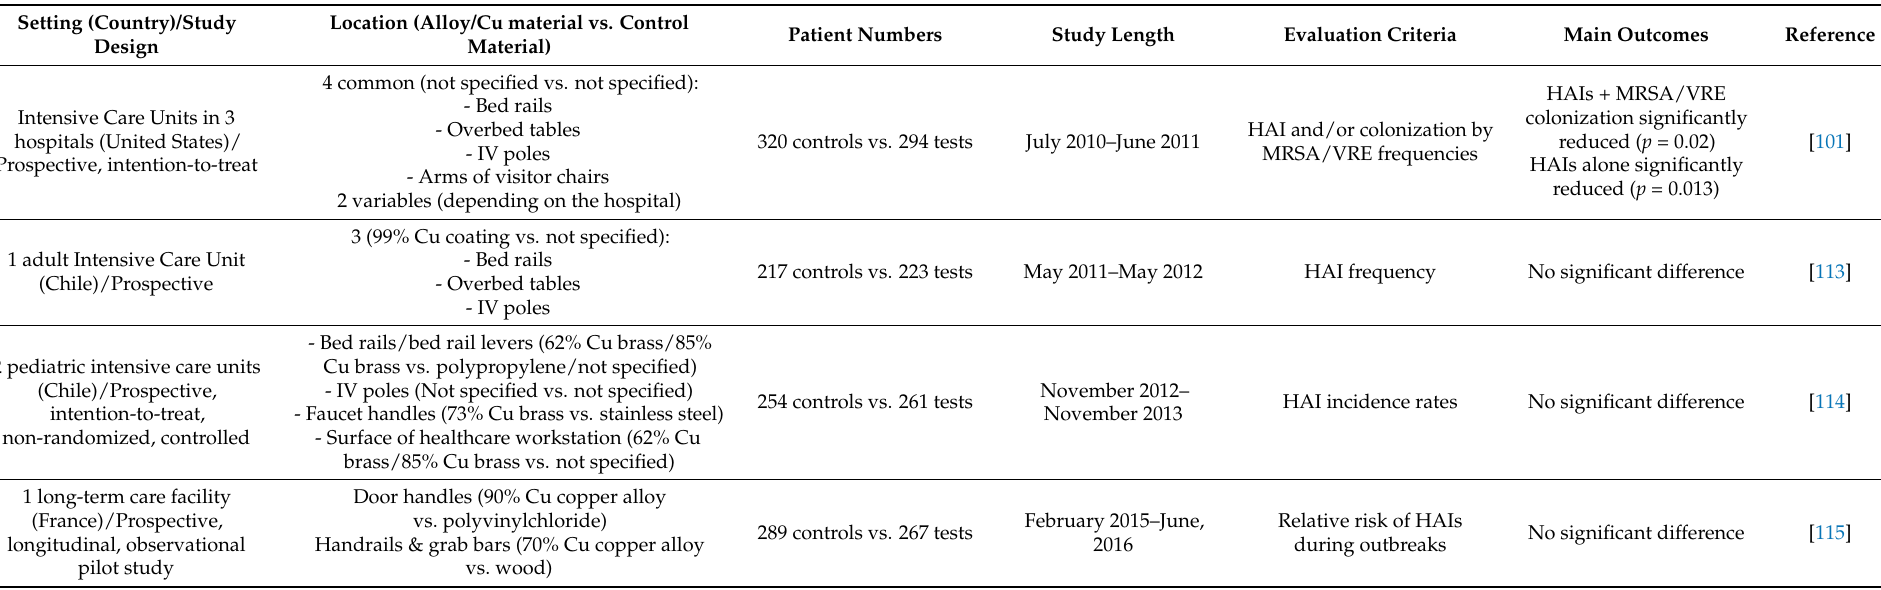
Table 2. Main characteristics of field trials on the reduction of hospital-acquired infections by brass alloys and copper-containing